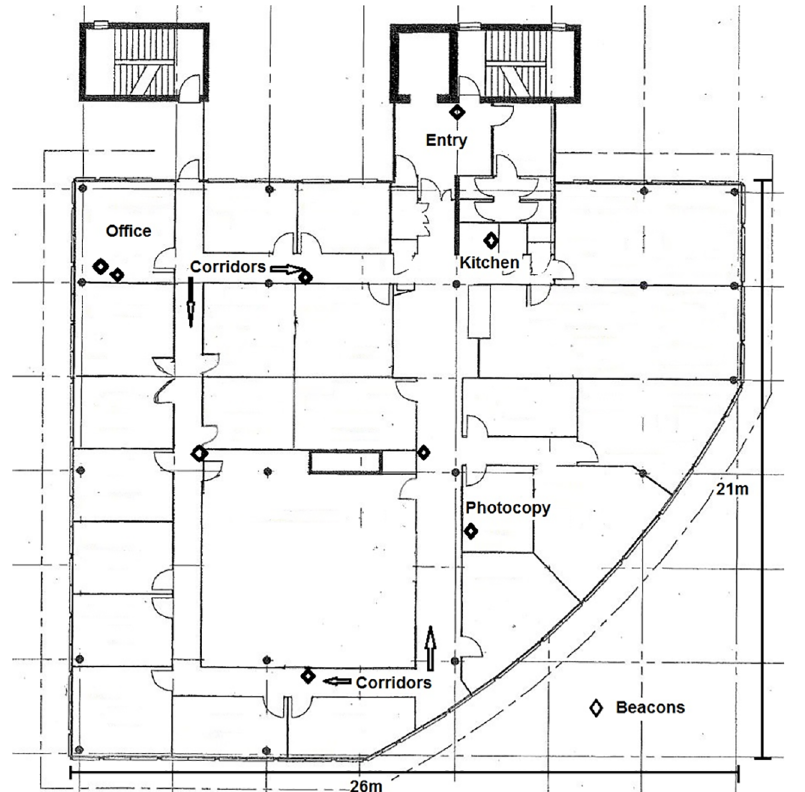
Fig 1. Typical layout of workplace floor and beacon